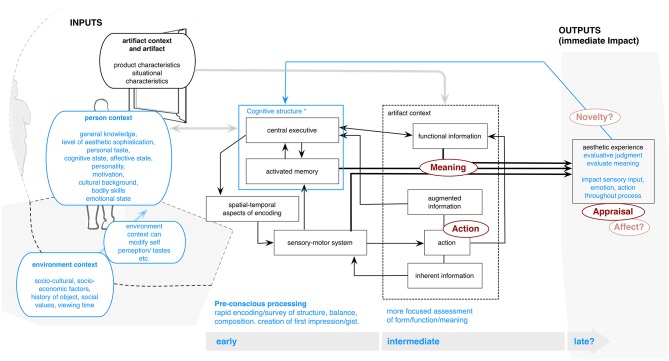
Locher model (adapted from Locher, 1996; Locher et al., 2010).